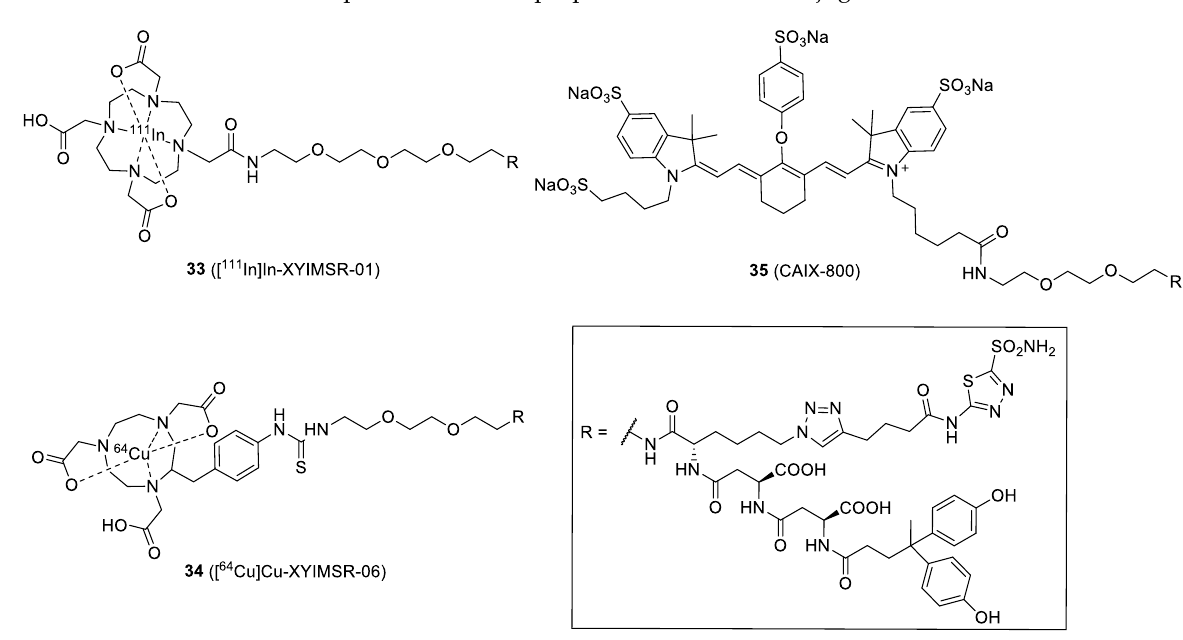
Figure 11. Chemical structures of the dual-motif CAIX-targeted probes.